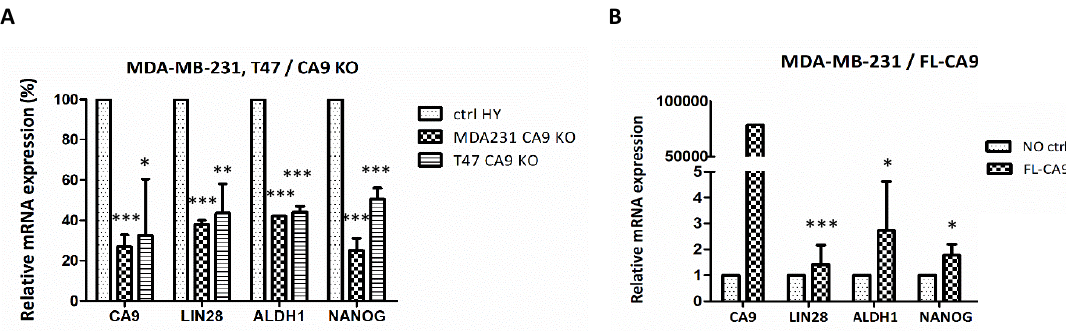
Figure 5. ( A ) The effect of CAIX knockout on mRNA expression of LIN28 and some stem cell markers in MDA-MB-231-CA9-KO and T47D-CA9-KO cells. ( B ) Impact of CAIX overexpression in stably transfected MDA-MB-231 on the expression of the same genes set. mRNA expression was normalized to actin and was presented as a percentage of hypoxic control parental cells. The results represent the mean from three independent biological experiments performed in triplicates. p > 0.05 was considered nonsignificant (ns), p < 0.05 is denoted as *, p < 0.01 as ** and p < 0.001 as